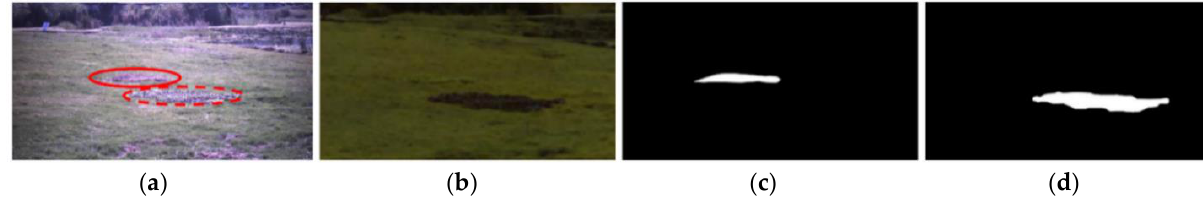
Figure 5. ( a ) The visible image of the Lawn scene, where the ASRC-net is circled by the solid line and the AIRC-net is circled by the dashed line; ( b ) The false-color image of the Lawn scene; ( c ) The reference image of the ASRC-net; ( d ) The reference image of the AIRC-net.